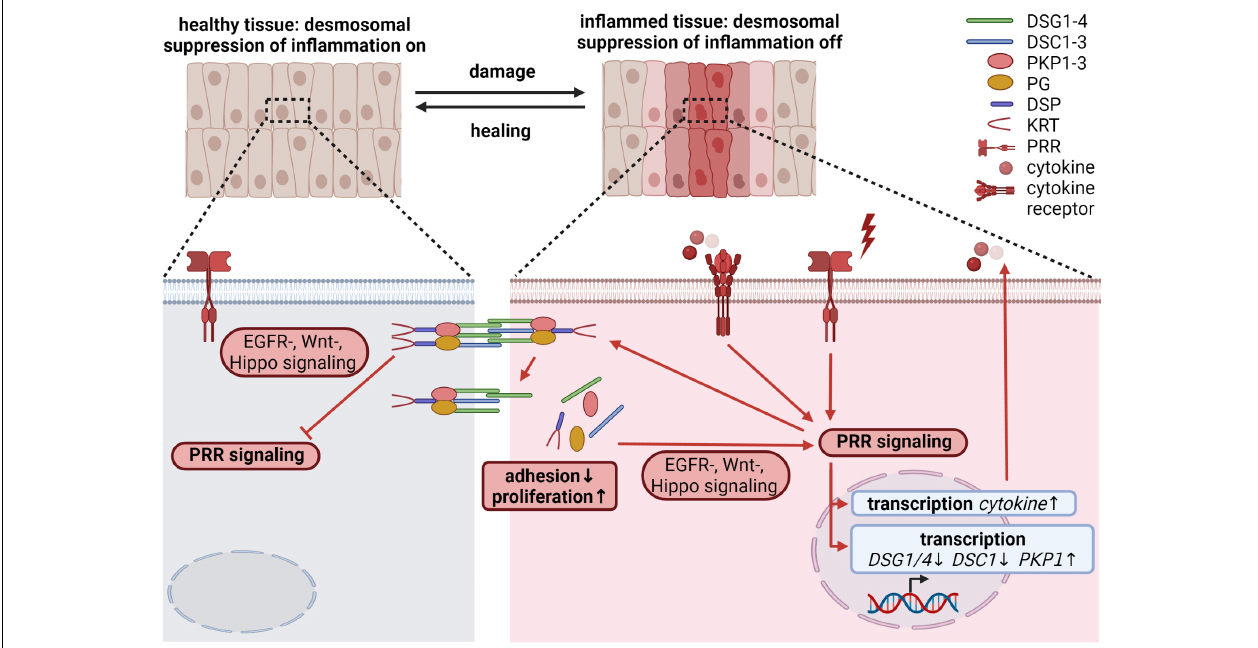
FIGURE 5 | Desmosomal proteins regulate inflammatory processes during wound healing (created with biorender.com) . Activated PRR signaling through intrinsic or extrinsic insults as well as upon tissue wounding induce signaling cascades affecting the amount and/or the localization of desmosomal proteins and thus cellular cohesion and proliferation. Moreover, through interfering with various signaling pathways including p38MAPK, Wnt, and Hippo signaling, desmosomal proteins are able to modulate inflammatory responses. Since most desmosomal proteins have been described to dampen inflammation, these proteins could be required to locally restrict inflammatory responses and/or ensure the resolution of inflammatory responses required for tissue regeneration.